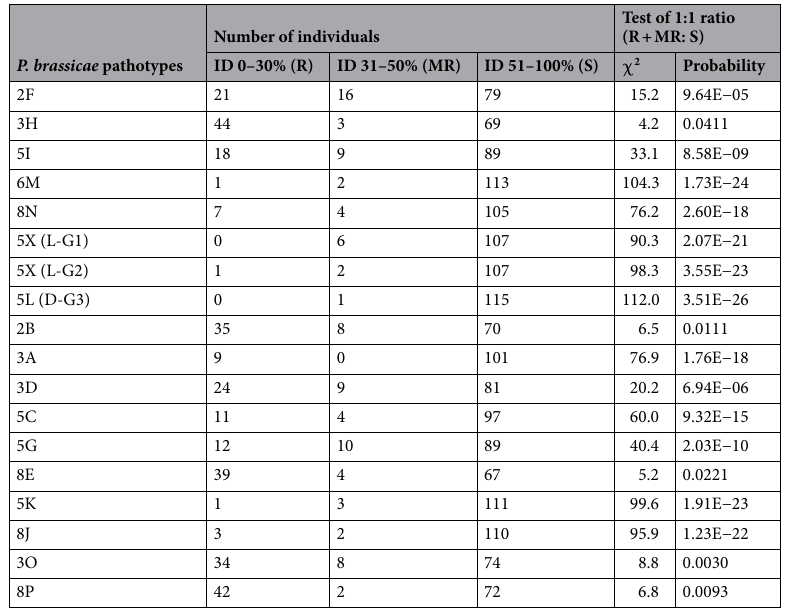
Table 2. Chi-square tests for 1:1 segregation ratio for doubled haploid (DH) lines produced from F 1 plants obtained from the cross ‘11–99’ ( Brassica napus cv. ‘Tosca’ (clubroot resistant) × ‘12–1’ (clubroot susceptible)) screened for resistance to 18 Plasmodiophora brassicae isolates under greenhouse conditions. Plasmodiophora brassicae pathotype designations are based on the Canadian Clubroot Differential (CCD) set 15 . Pathotypes 2F, 3H, 5I, 6M and 8N are single-spore isolates collected prior to the introduction of clubroot resistant canola (Strelkov et al. 20 ; Xue et al. 21 ). Pathotypes 5X (L-G1 and L-G2) and 5L are field isolates collected in 2013 (Strelkov et al. 18,20 ). Pathotypes 2B, 3A, 3D, 5C, 5G and 8E are field isolates collected in 2014 (Strelkov et al. 20,22 ). Pathotypes 5K and 8J are field isolates collected in 2015 (Strelkov et al. 20,23 ). Pathotypes 3O and 8P are field isolates collected in 2016 (Strelkov et al. 20,24